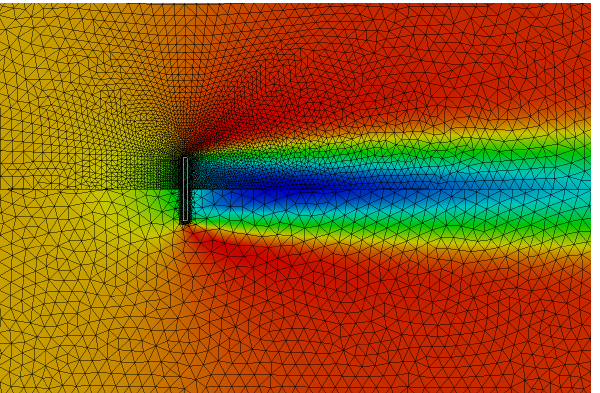
Figure 13. Boundary tight vs. level set meshes. On the top half we have the boundary tight generated mesh, whereas in the top bottom we have the level set